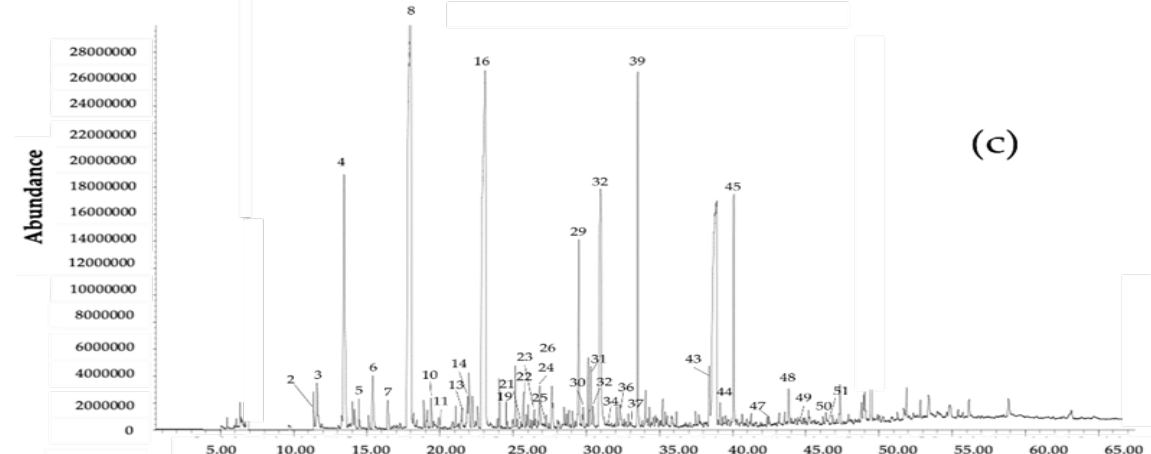
Figure 1. GC chromatogram of F7 (dichloromethane 90%:methanol 10%) of different baijiu samples: (a) Wuliangye; (b) Moutai; (c) Fengjiu. Note: (1) 2-pentanone; (2) 2-butanol; (3) 1-propanol; (4) 2-methyl-1-propanol; (5) 3-methyl-2-butanol;